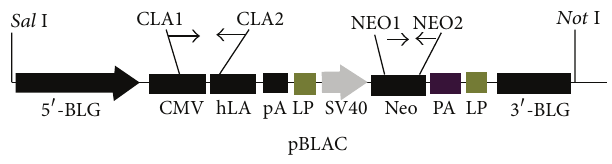
Figure 1: Schematic representation of pBLAC construct. 5 󸀠 -BLG: goat 𝛽 -lactoglobulin promoter; CMV: human cytomegalovirus immediate early promoter; hLA: human lactalbumin gDNA; pA: SV40 early mRNA polyadenylation; LP: LoxP sequence; SV40: simian vacuolating virus 40 promoter; Neo: neomycin resistance gene; 3 󸀠 -BLG: 𝛽